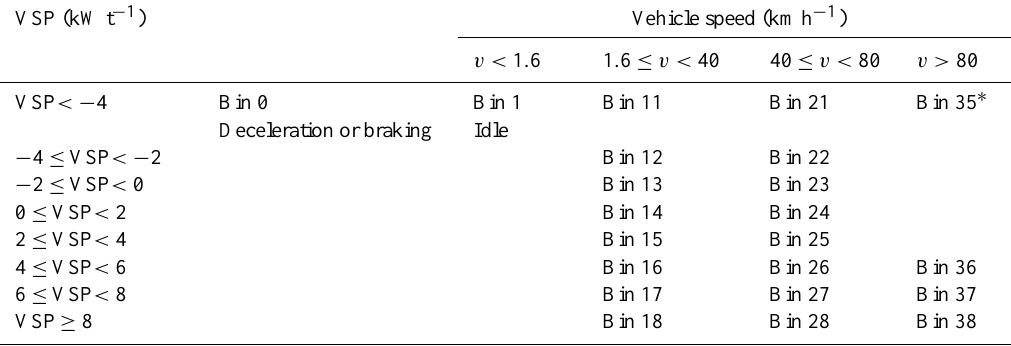
Table 4. Definition of operating mode bins by using VSP and vehicle speed ( v ).